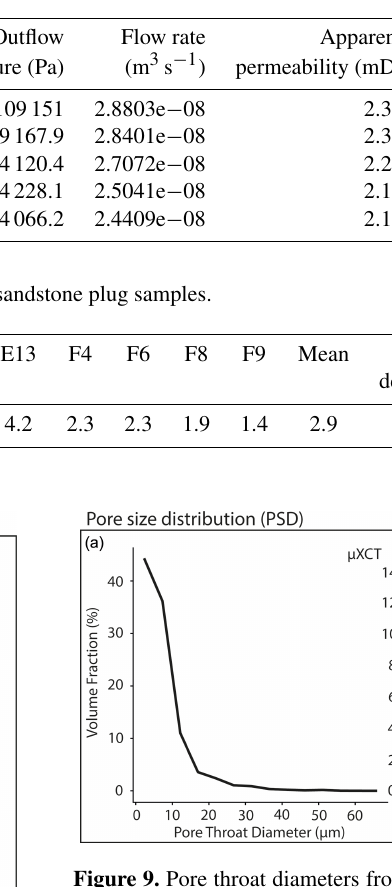
Table 1. Parameters of the gas permeameter flux experiment (sample F8), including measured helium gas flow rate, recorded inflow and